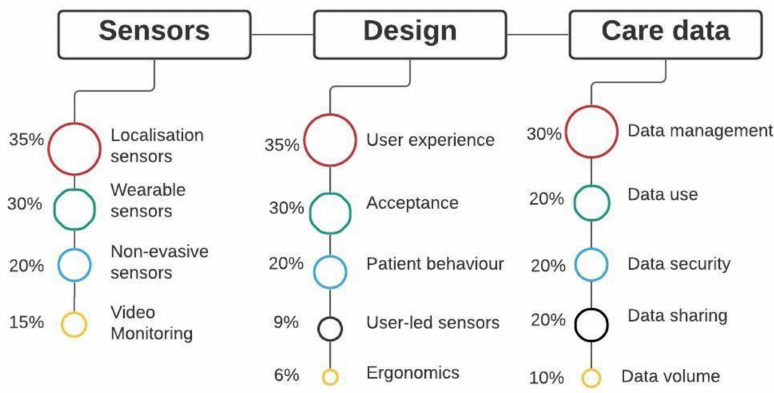
Figure 4. Results showing the main themes and